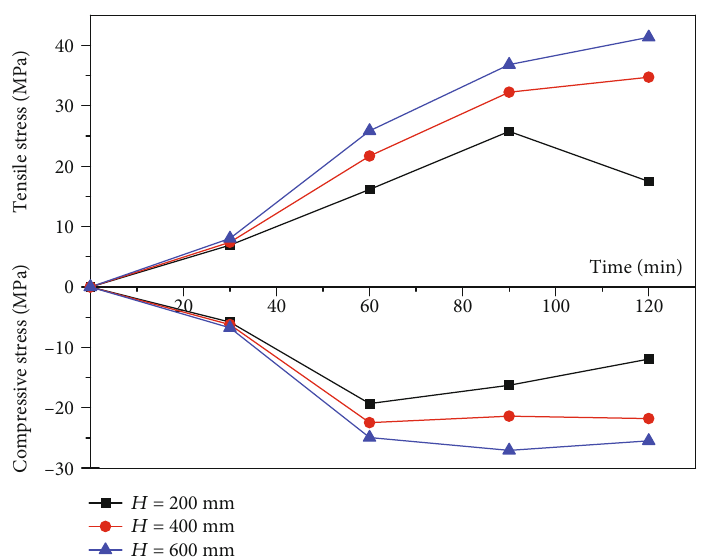
Figure 15: Maximum additional axial stress of pipelines under di ff erent buried